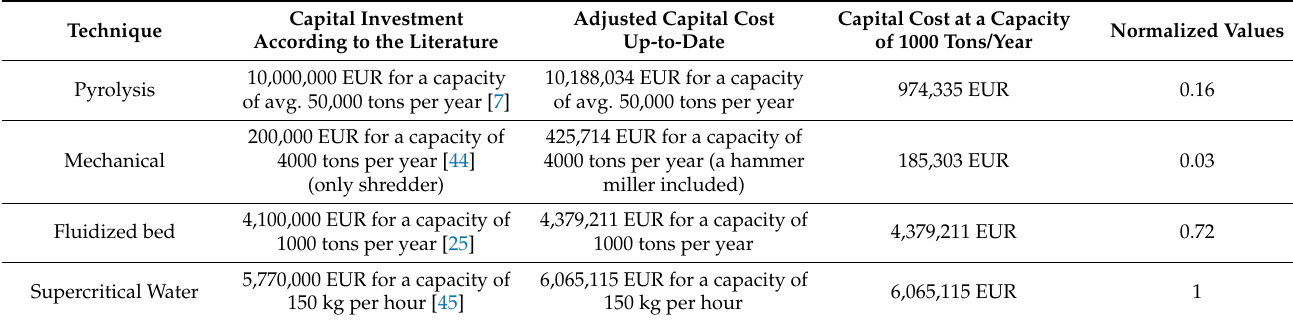
Table 4. Capital investments for recycling techniques.